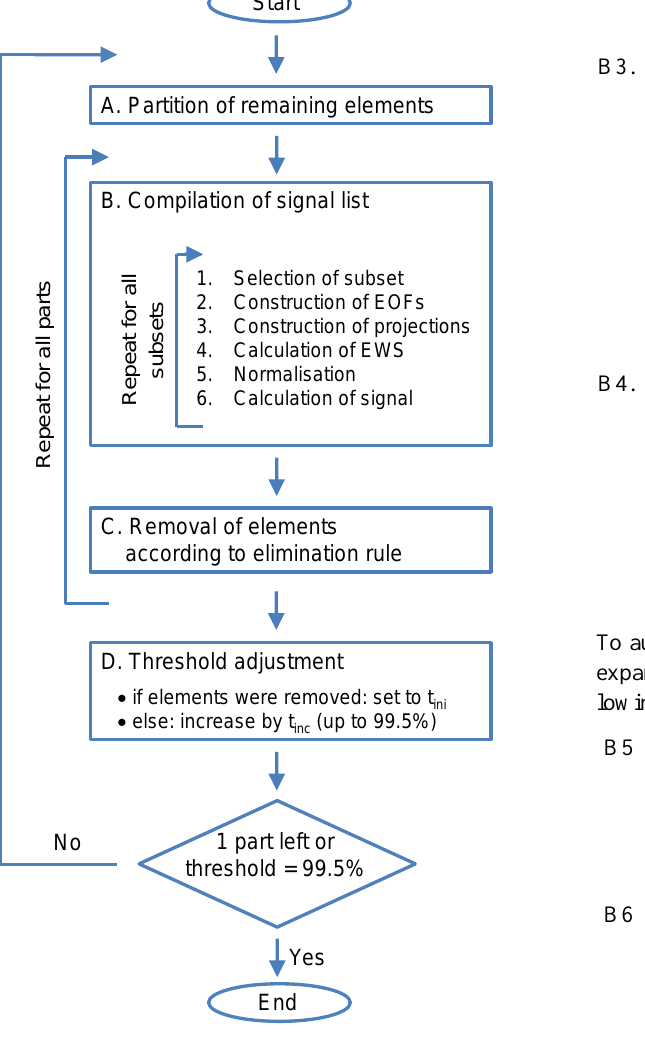
Fig. 6. General flowchart of the hotspot detection